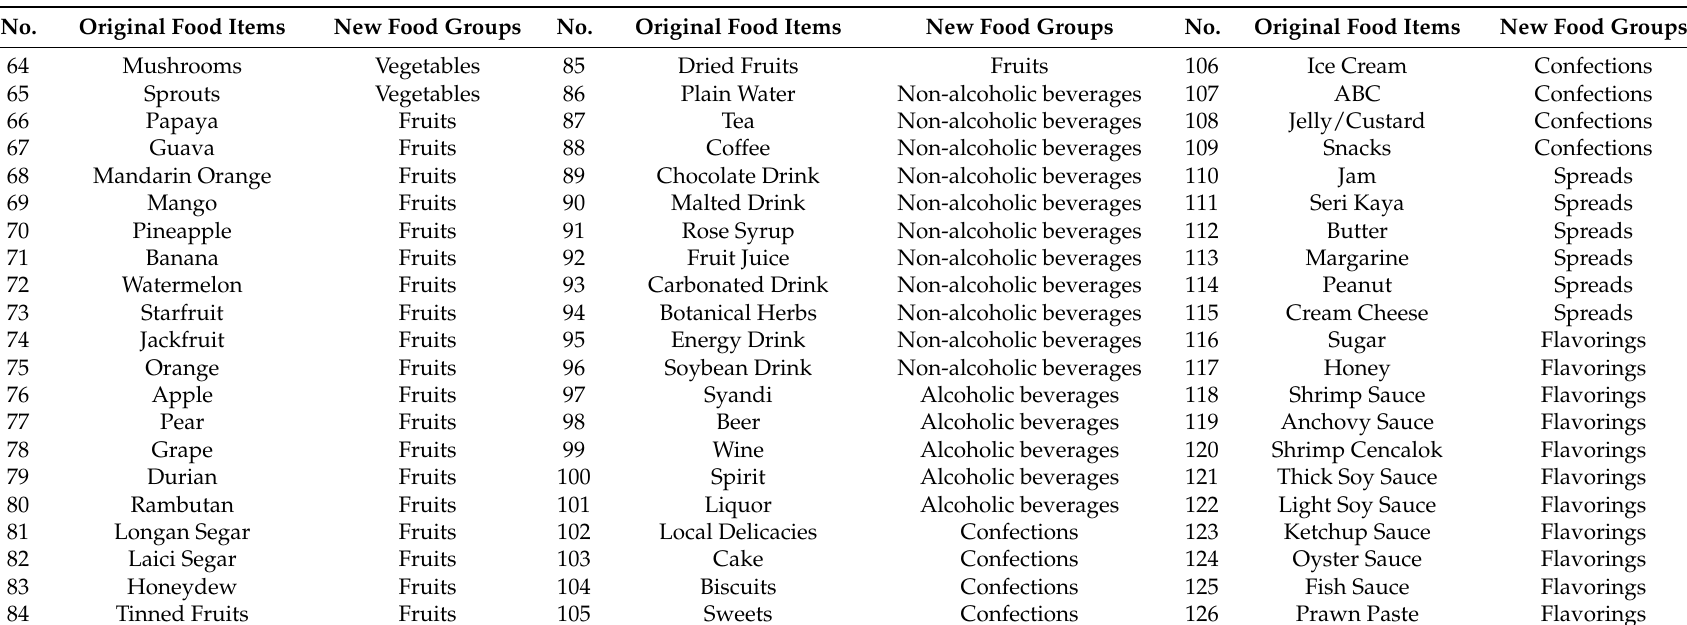
Table A2. List of 126 food items grouped into 17 food item